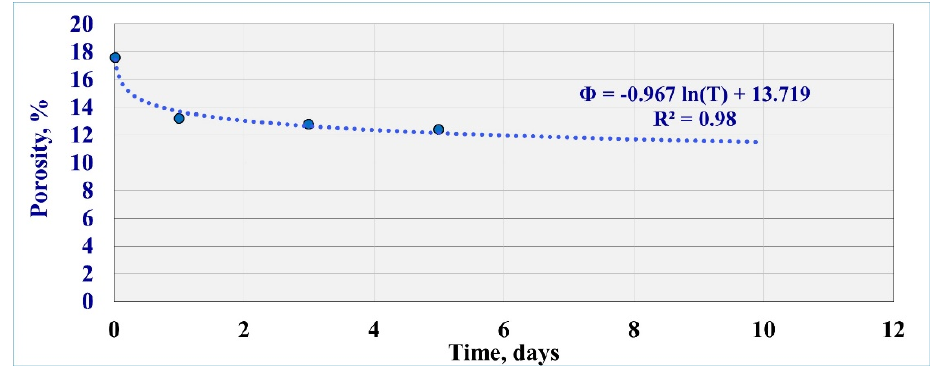
Figure 9. Porosity reduction as a function of the extended exposure time.